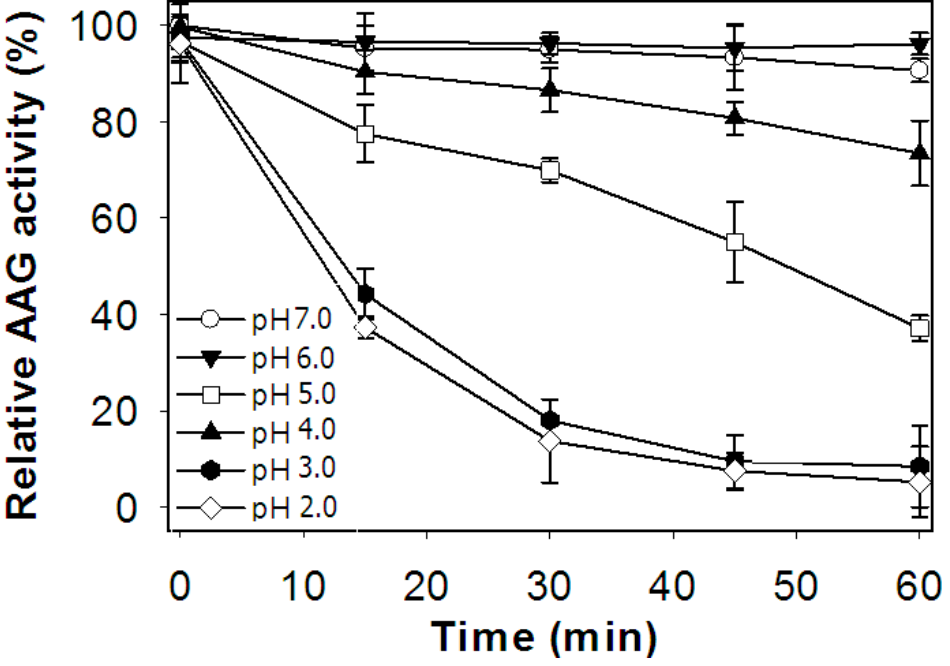
Figure 6. Effect of pH on the stability of TKU004P.